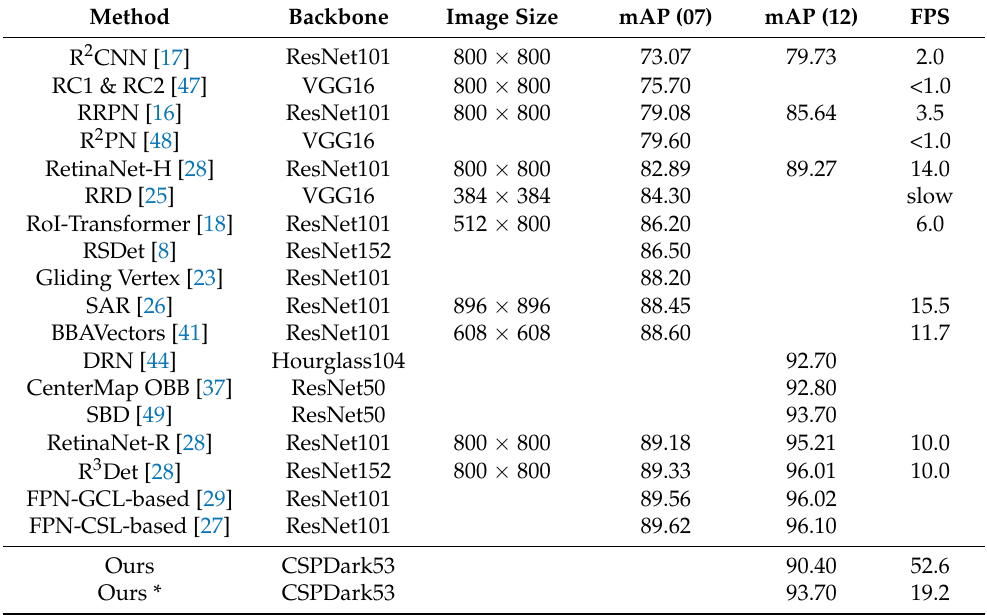
Table 3. The comparison results on